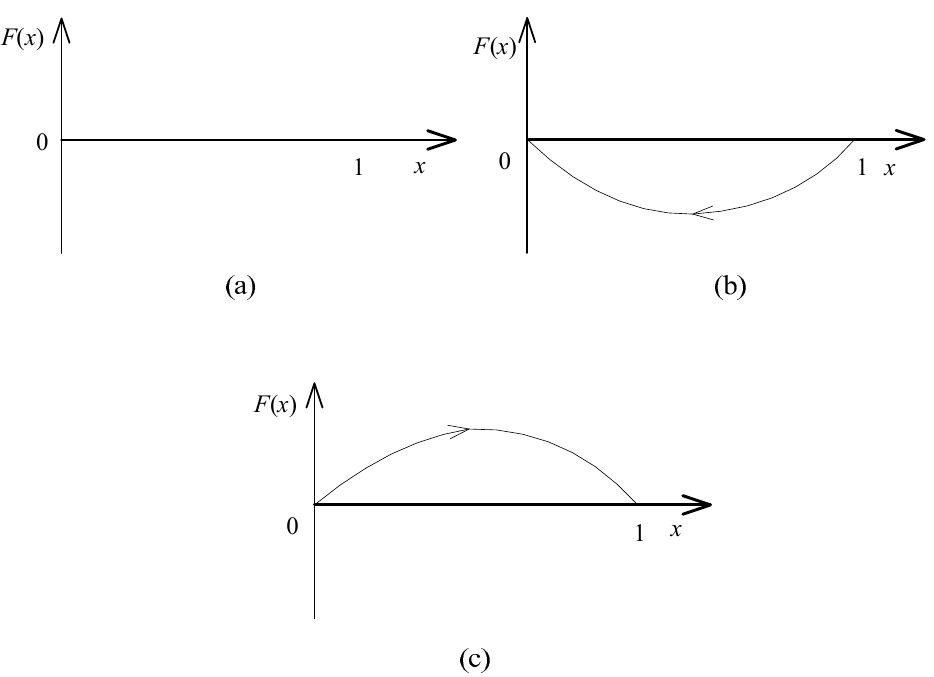
Figure 1. The dynamic evolutionary diagram of the government under various cases. ( a ) The dynamic diagram of governmental strategy when y = y ∗ . ( b ) The dynamic diagram of governmental strategy when x = 0 is an evolutionary stable state. ( c ) The dynamic diagram of governmental strategy when x = 1 is an evolutionary stable state.